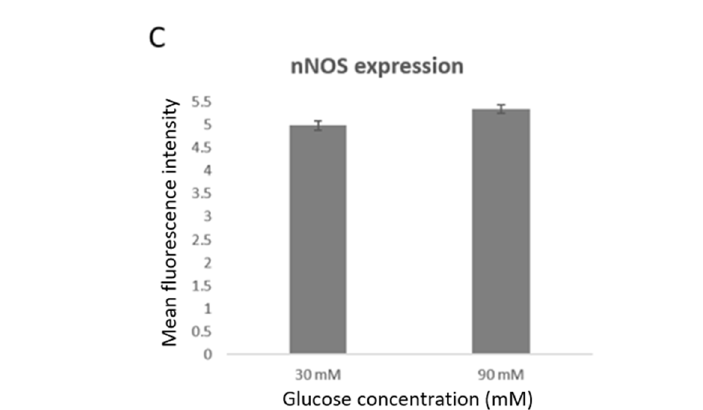
Figure 10. The expression of nNOS (gray) and PDGFR α (yellow) cell surface markers in differentiated PDGFR α -positive cells with nuclei counterstained with DAPI (blue). ( A ). Cells treated with 30 mM glucose. ( B ). Cells treated with 90 mM glucose. Merged images show expression of nNOS at 90 mM compared to 30 mM glucose concentration and due to the low number of cells that were used in imaging studies, the difference in expression of nNOS at 90 mM and 30 mM was not as clear as in the gene and protein expression. ( C ). The mean of fluorescence intensity of the signals for the stained cells that was extracted from the software image J after analysis of the pictures. Scale bar = 50 µ m.